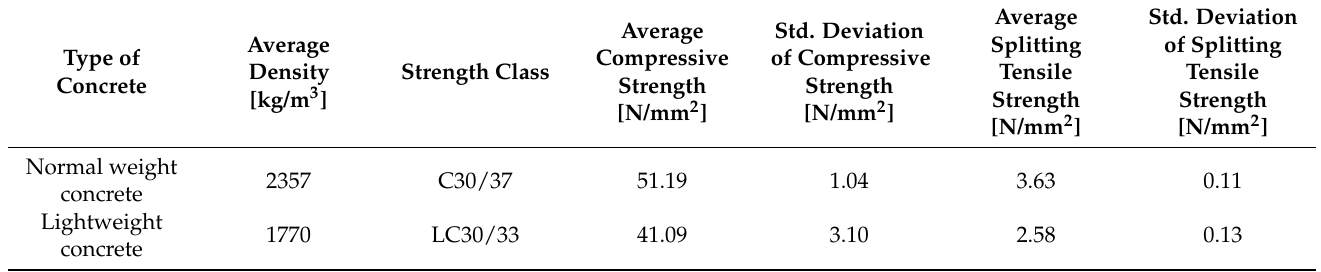
Table 1. Density, compressive and splitting tensile strength of the normal and lightweight